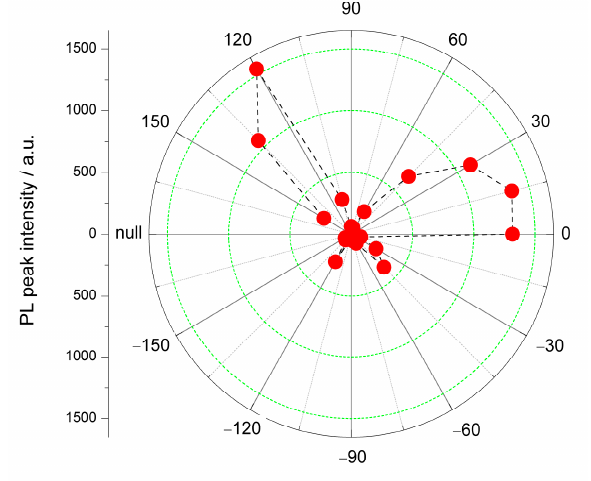
Figure 8. Detection angle-dependent PL peak intensity distribution of Alq 3 (Ag NWs), with the angle between the detection direction and the normal line ranges from − 150° to 150°, in steps of 15°.